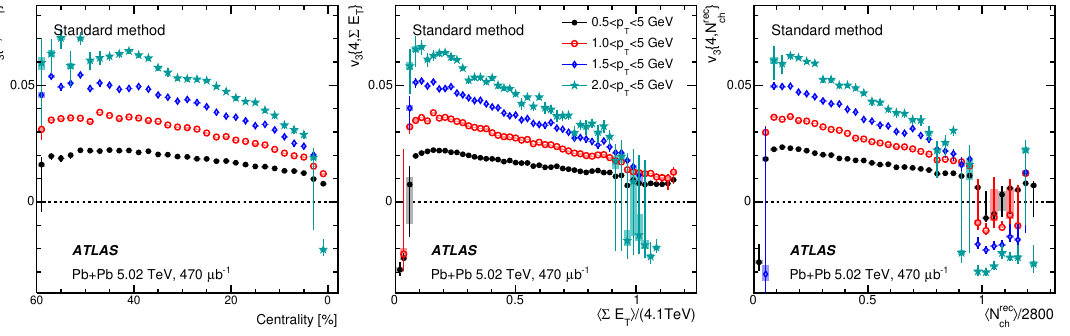
Figure 22 . The v 3 f 4 g values calculated for charged particles in four p T ranges as a function of centrality (left panel), (cid:6) E T (middle panel), and N rec boxes represent the statistical and systematic uncertainties, respectively. Zero is indicated by a dotted line.